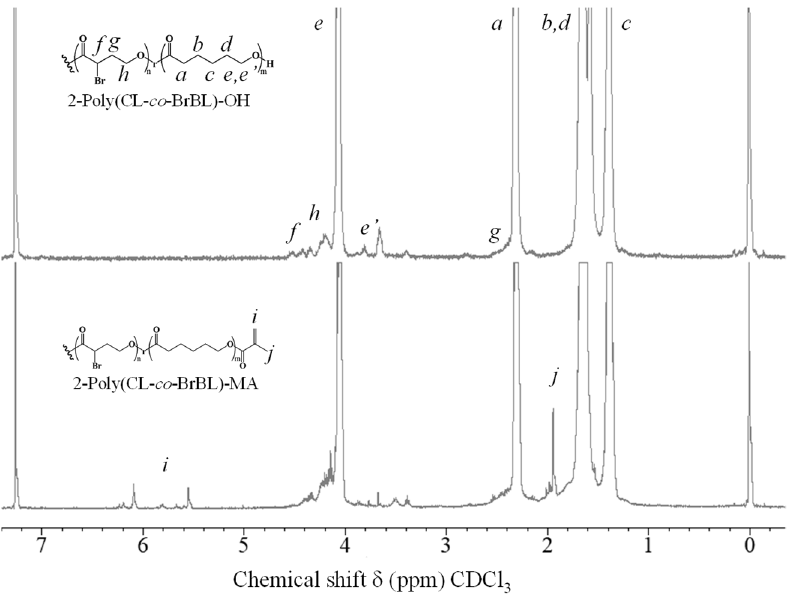
Figure 3. 1 H-NMR spectra of 2-poly(CL-co-BrBL)-OH as a precursor and 2-poly(CL-co-BrBL)-MA as a macromonomer. The spectra (d, ppm) were recorded with TMS as standard in CDCl 3 .